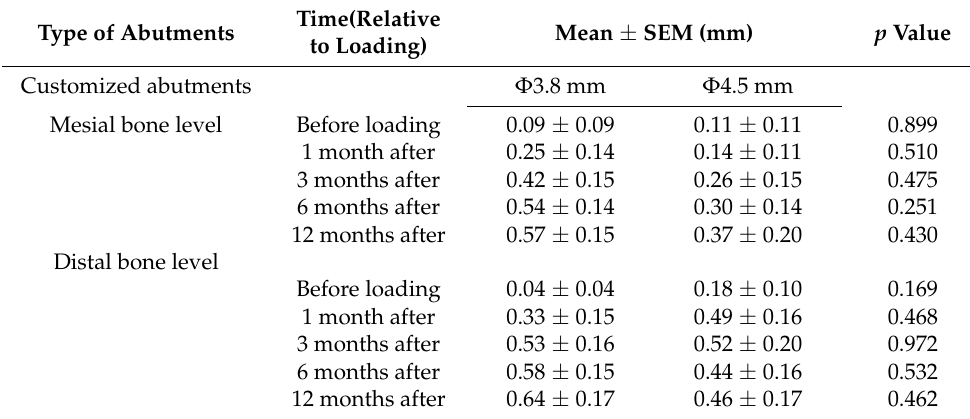
Table 10. Comparison of the mesiodistal marginal bone levels of the groups by the implant diameter of the CAs. CA, customized abutment; SEM, standard error of measurement.